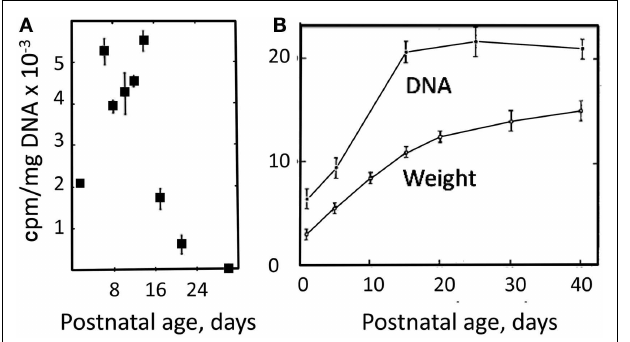
FIGURE 8 | (A) Rate of DNA synthesis, measured in unincubated brain slices by incorporation 14 C after [ 14 C]thymidine exposure 12h earlier. From Schousboe (1972). (B) Developmental increase in weight and DNA content of rat brain. From Mori et al. (1970).